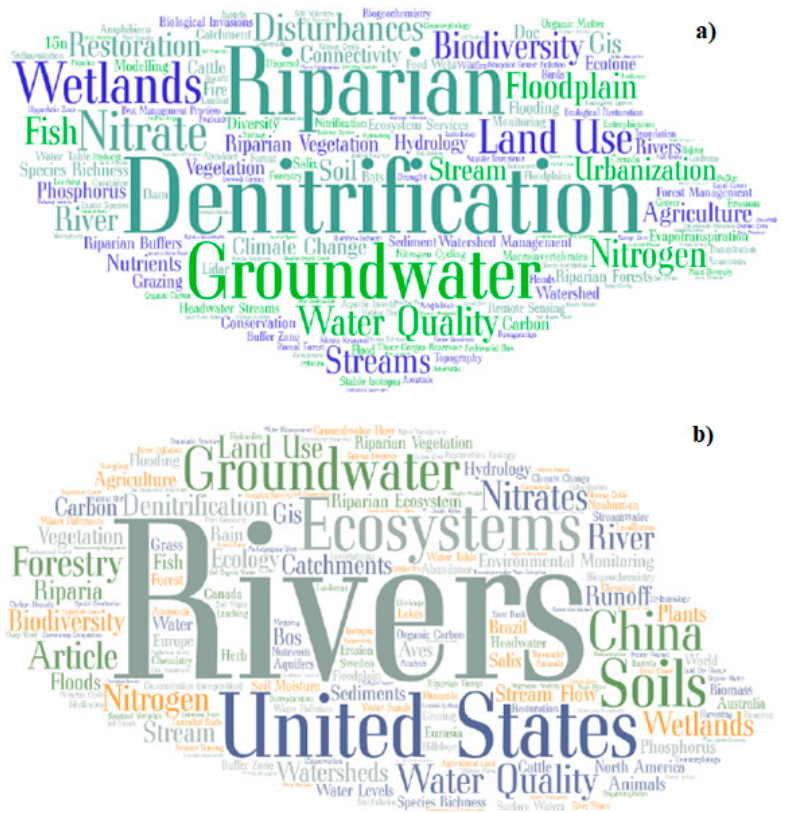
Figure 7. Word cloud of ( a ) authors’ keywords and ( b ) KeyWords Plus ® , excluding the terms “riparian zone(s)” and “ri- parian area(s)”.